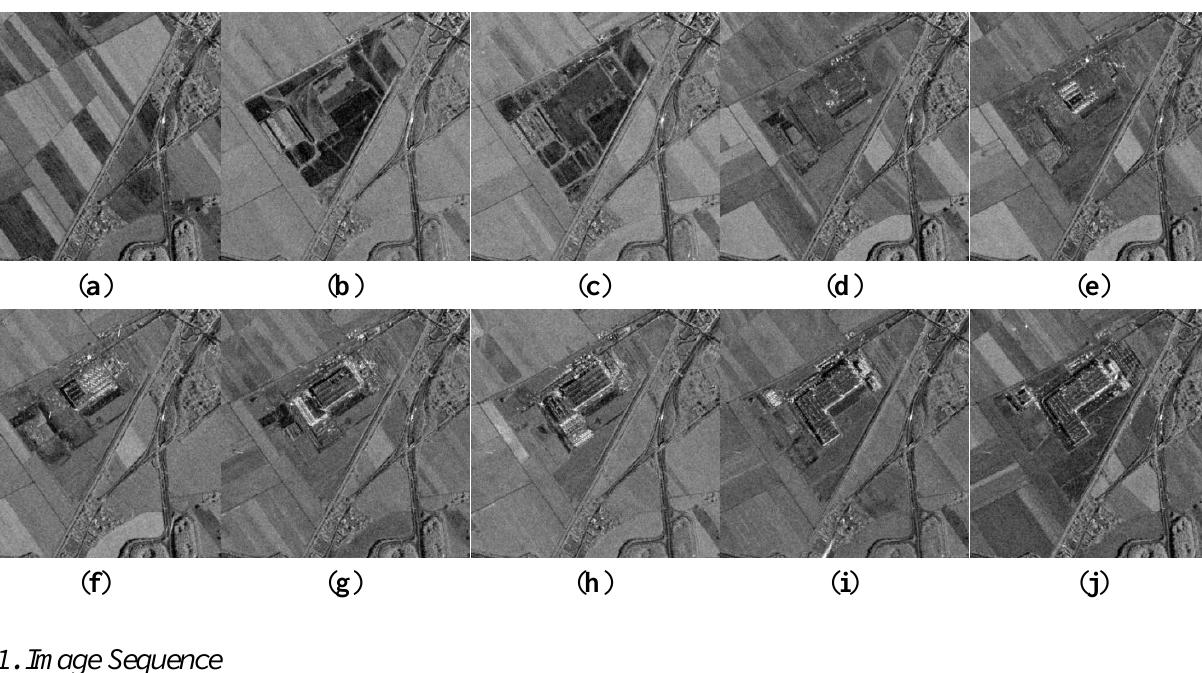
Figure 21. Subset of TerraSAR-X high resolution spotlight time series over Ludwigshafen acquired during several overflights between May 2008 and July 2010: ( a) 9 May 2008. ( b) 4 December 2008. ( c) 13 March 2009. ( d) 23 July 2009. ( e) 25 August